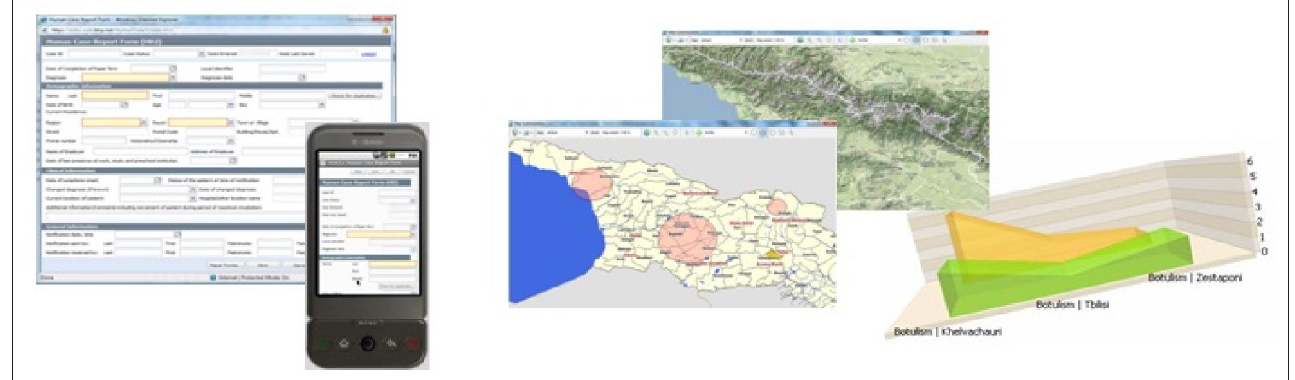
FIGURE 2: Web and/or handheld access to Electronic Integrated Disease Surveillance System: data